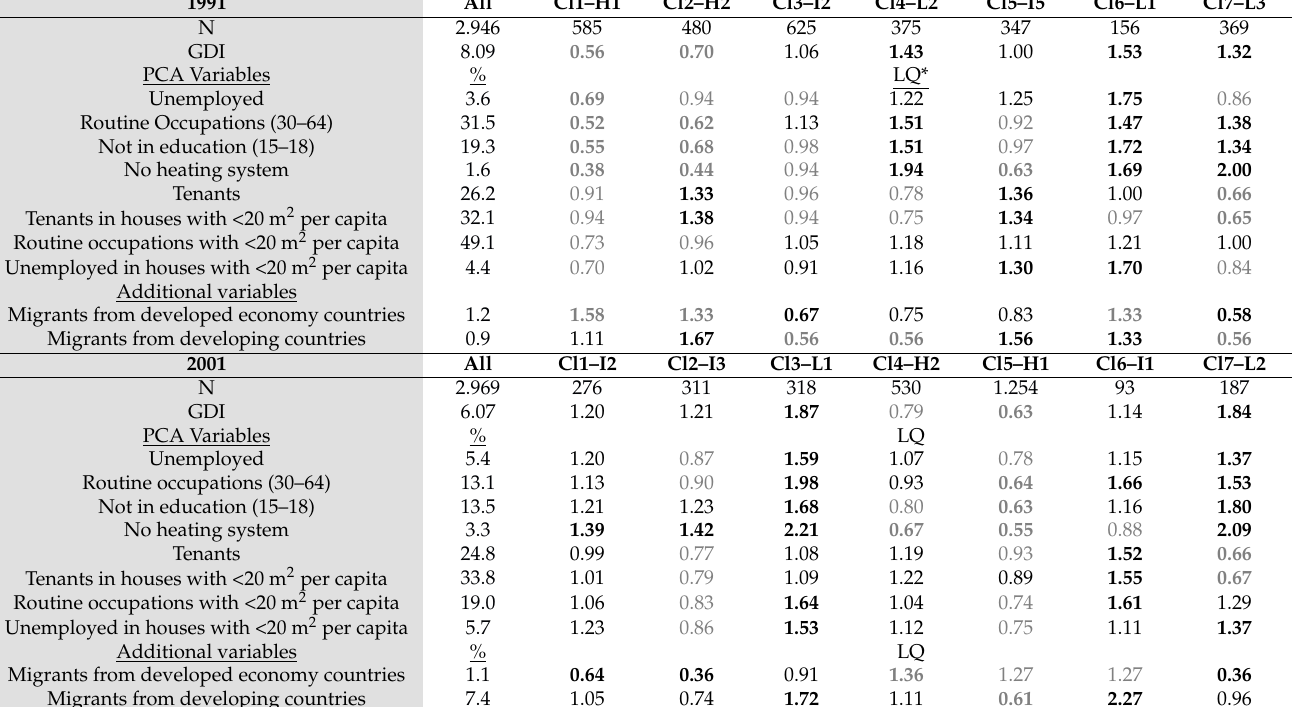
Table 4. Profile of deprivation clusters (1991, 2001, 2011). Location